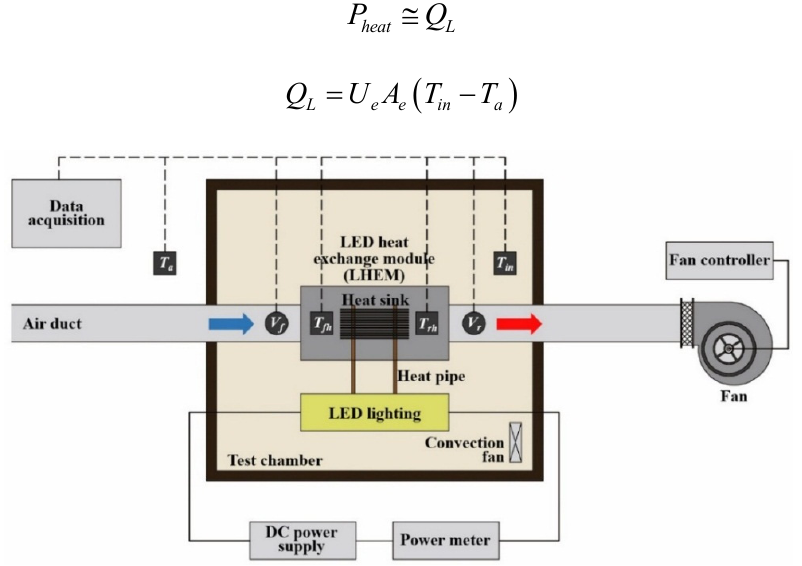
Figure 3. Operational illustration of the thermal management system with the